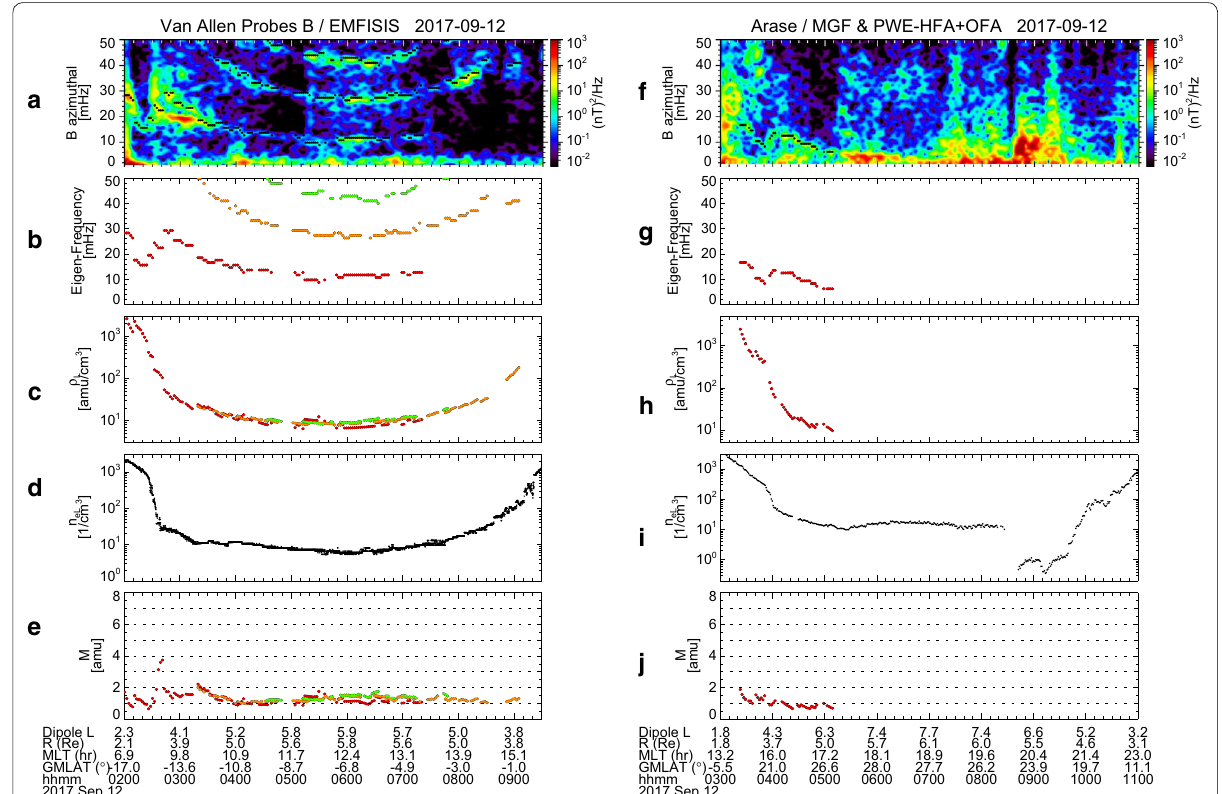
Fig. 4 Van Allen Probe B observations of a the dynamic power spectrum of the magnetic field variations in the azimuthal component with selected peak frequency indicated by black dots, b the selected peak frequency, c mass density at the satellite position, d electron density at the satellite position, and e average plasma mass, during 02:00–09:30 UT on 12 September 2017. In b – e , colors indicate results of different eigen-frequencies, that is, fundamental ( f 1 ): red, second harmonic ( f 2 ): orange, and third harmonic ( f 3 ): green. f – j Same as in a – e but for the Arase observations during 03:00–11:00 UT on 12 September